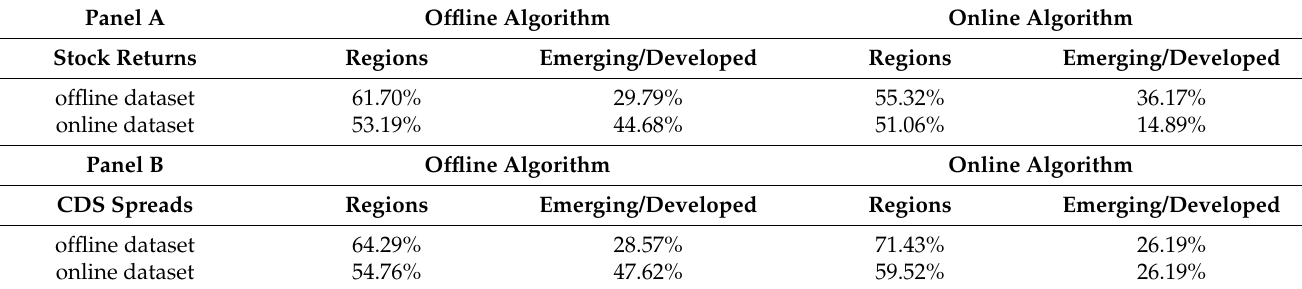
Table 2. The misclassification rates of clustering algorithms on different datasets. The clustering facts are geographical region and development level, respectively. Panel A presents the results from clustering global stock indexes, and Panel B presents the results from clustering sovereign CDS spreads.